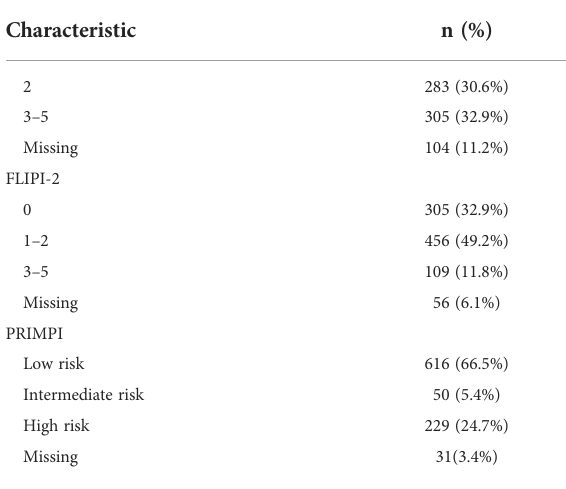
TABLE 1 Baseline characteristics of the patients with FL